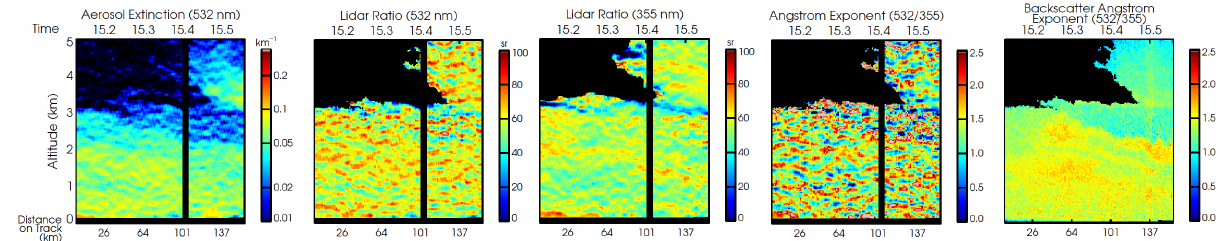
Figure 2. Curtain plot of the HSRL-2 measurement on 17 July 2012, 15:12–15:55UTC. The time axis is in decimal hours. The distance flown during this time is shown on the bottom x axis. Shown are the mean values of the profiles of (a) the extinction coefficient at 532, the lidar ratios at (b) 532 and (c) 355nm, (d) the extinction-related and (e) the backscatter-related Ångström exponent at 355 / 532nm. Each profile is based on a 10s signal sampling rate. The vertical resolution is 150m.